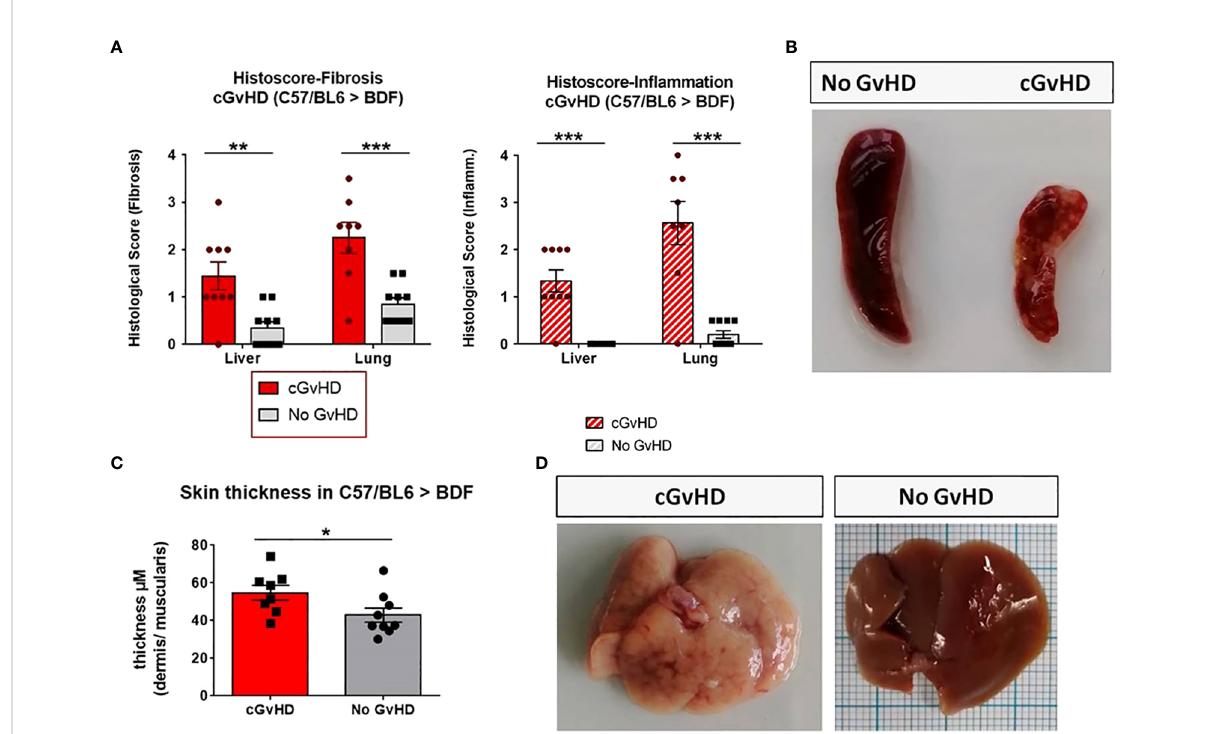
FIGURE 4 Clinical organ manifestations of cGvHD in C57BL/6 ➔ BDF1 at day +125 after allo-HCT. (A) Histological quanti fi cation of fi brosis and in fl ammation in liver and lung of each individual mouse, based on histo-scoring ranging from 0=no to 4= severe fi brosis/in fl ammation. Error bars show mean ± SEM. n=9 (cGvHD); n=10 (No GvHD). Representative data from one out of four experiments. *P<0.05, **P<0.01, ***P<0.001by unpaired students t- test. (B) Spleen of cGvHD vs. non-GvHD mouse at d+125 after transplantation with visible sclerotic and apoptotic changes in cGvHD. (C) Skin thickness was increased in cGvHD vs. non-GvHD. Thickness was estimated by measurement of dermis-muscularis-ratio in Masson ’ s Trichrome stainings. Error bars show mean ± SEM. n=8 (cGvHD); n=9 (No GvHD). Representative data from one out offour experiments. *P<0.05 by unpaired students t-test. (D) Livers of cGvHD vs. non-GvHD mouse at d+125 after transplantation with visible cirrhotic changes in